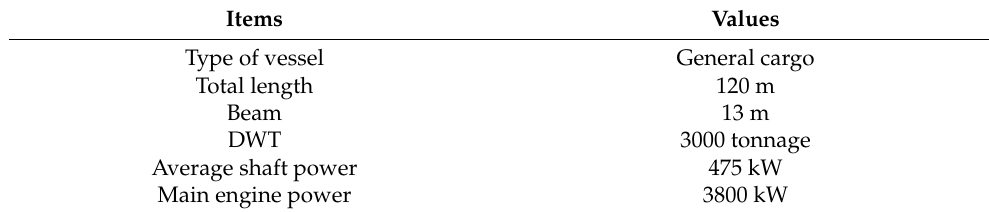
Table 1. General specifications of the target